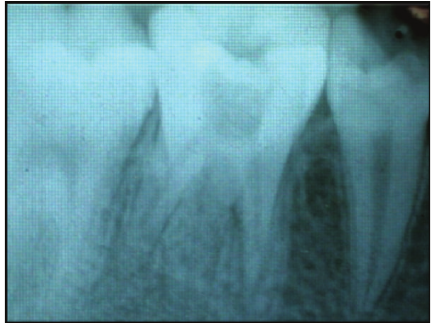
Figure 1: Preoperative IOPA of 36.